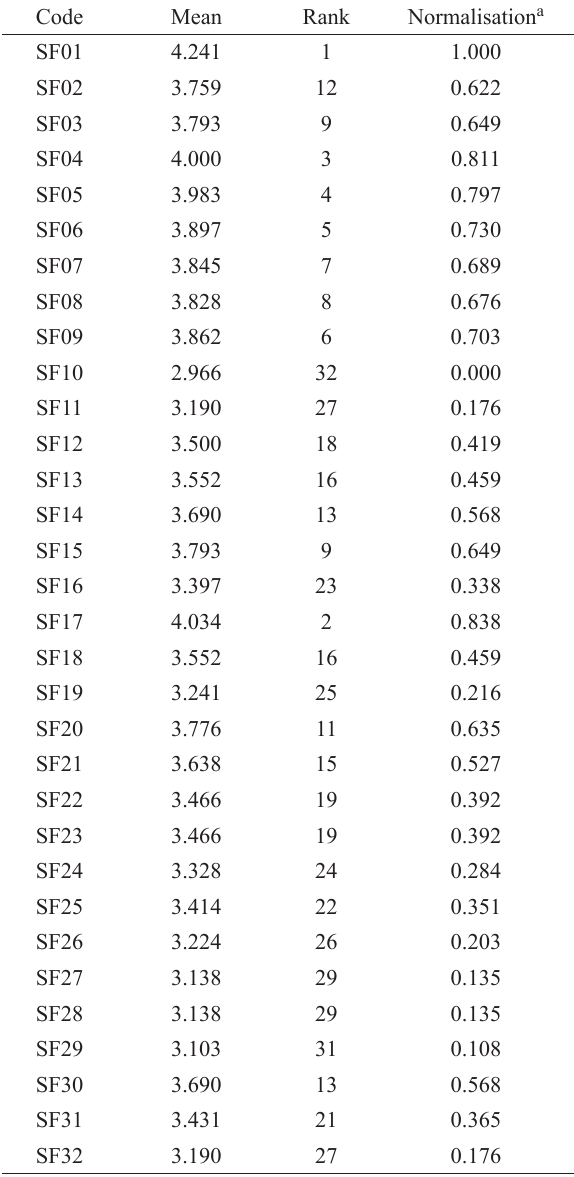
Table 3. Ranking of the success factors to enhance BIM